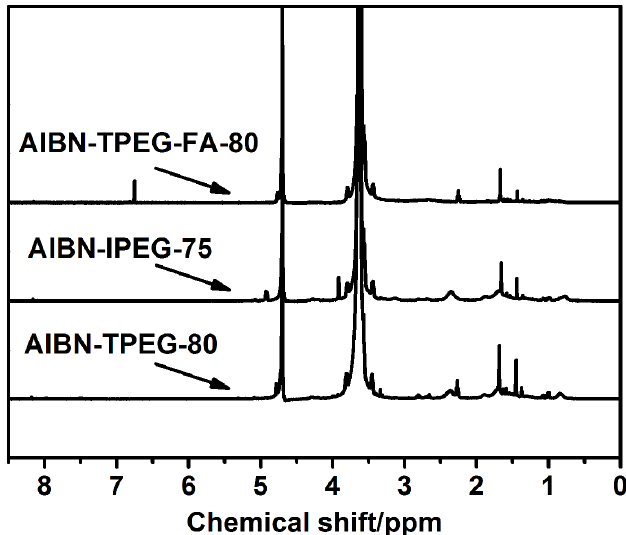
Figure 2. 1 H NMR spectra of PCEs (PCE samples: